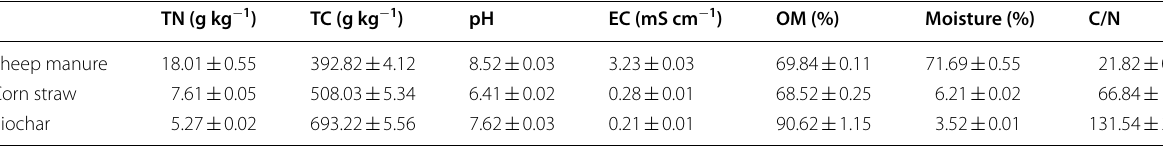
Values indicate mean standard deviation based on determination with three replications. TN (total nitrogen), TC (total carbon), EC (electricity conductivity), OM ± (organic